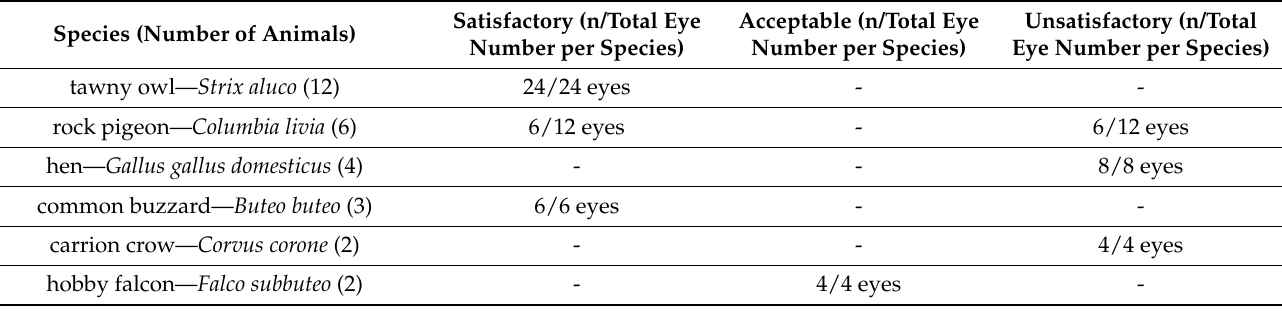
Table 3. Quality of fundus examination of birds examined with the Peek retina ®